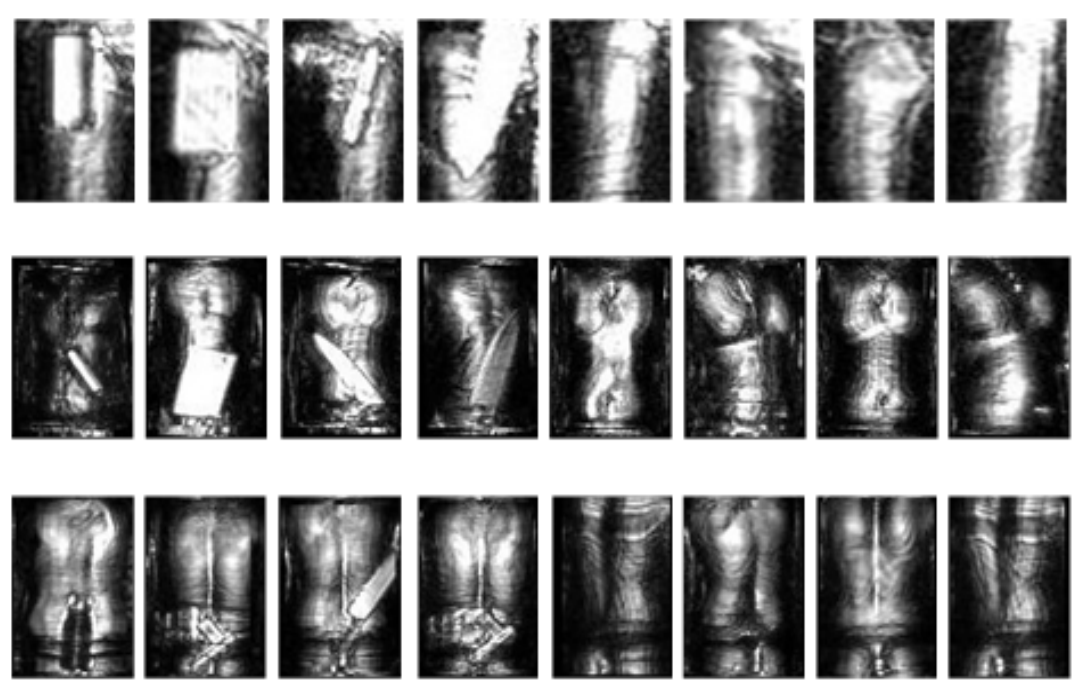
Figure 8. Body part